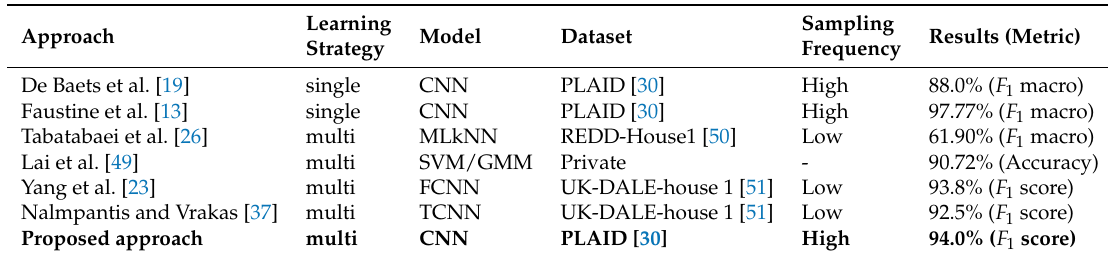
Table 1. Results